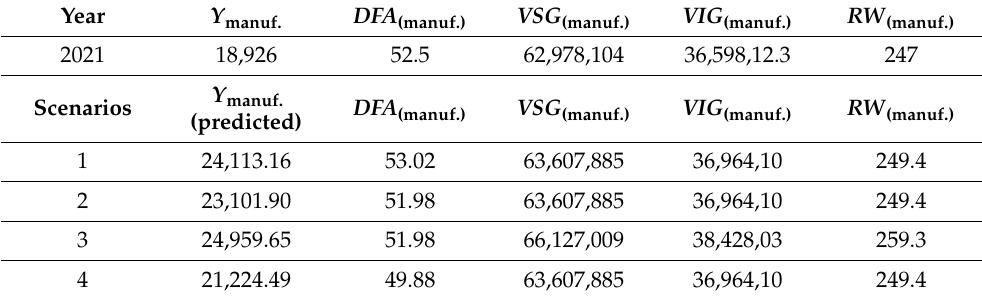
Table 10. Scenarios of changes in the efficiency of industrial systems in manufacturing industries.